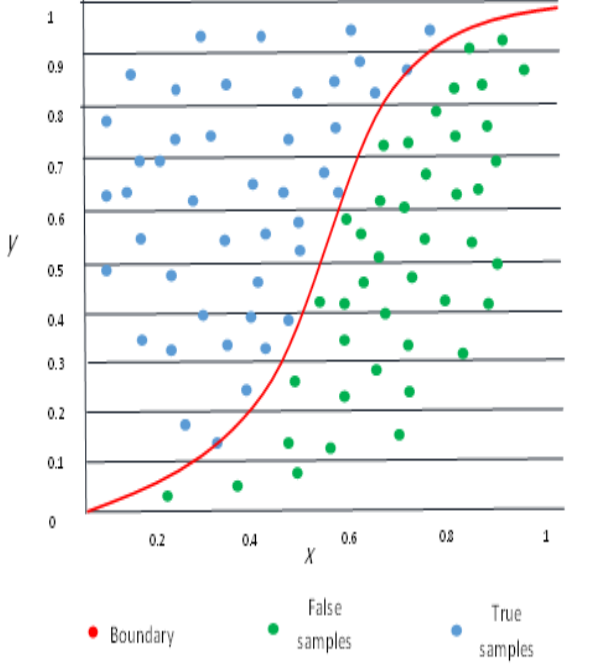
Figure 2. The logistic regression boundary